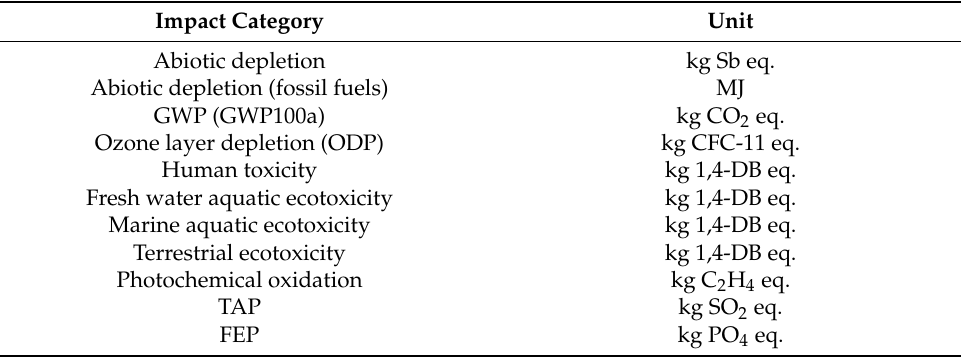
Table 1. The impact categories used for